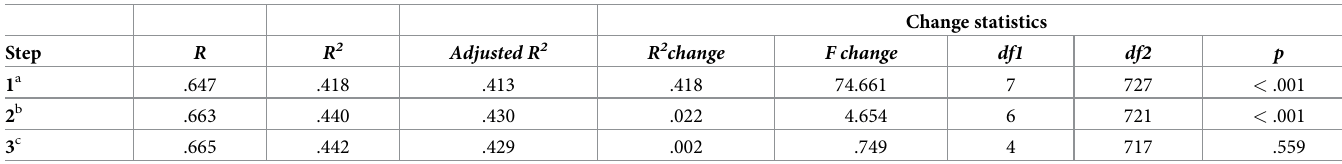
Table 6. Hierarchical cross-cultural model